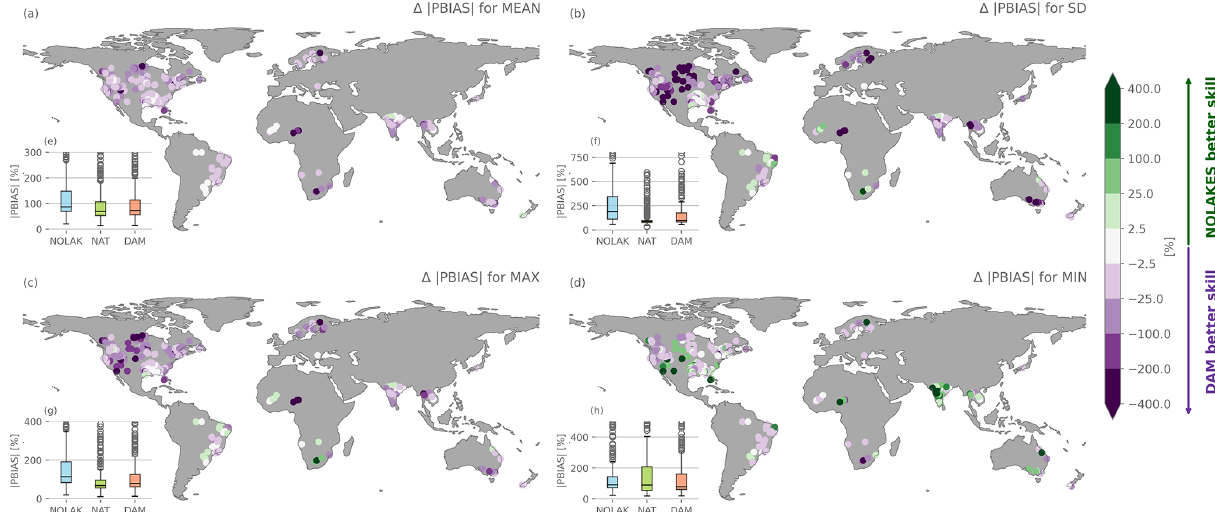
Figure 8. Performance of global-scale mizuRoute simulations for streamflow indices of GSIM. Added value in absolute percent bias of accounting for reservoirs (DAM) over simulations without lakes or reservoirs (NOLAKES) ( | PBIAS | DAM −| PBIAS | NOLAKES ) for monthly mean streamflow (MEAN, a ), monthly streamflow standard deviation (SD, b ), monthly maximum streamflow (MAX, c ) and monthly min- imum streamflow (MIN, d ). Note the non-linear colour bar scale. Inset panels (e) – (h) show the | PBIAS | for the simulation without lakes (NOLAKE), with only natural lakes (NAT), and accounting for reservoirs (DAM). Only GSIM stations on the river network, a maximum 200km 2 downstream of a reservoir, and with observations in the simulation period are